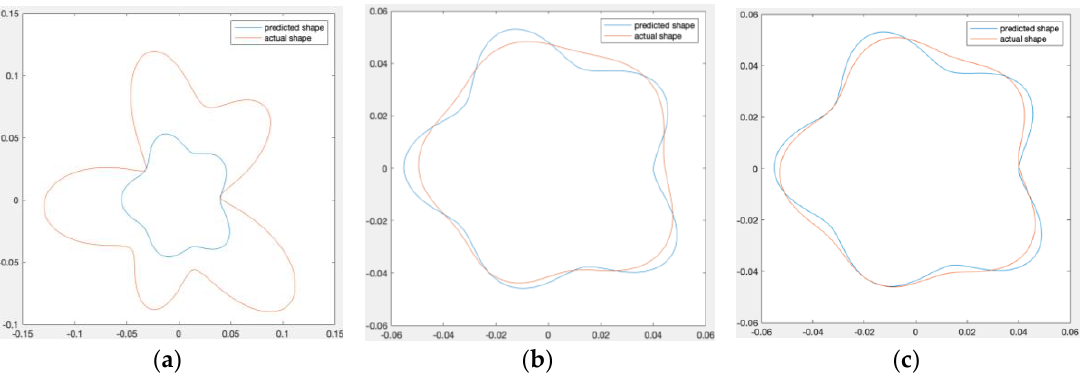
Figure 15. Section of the processed cylinder in position Z = 100mm: predicted data (blue) against actual shape (red). Decreasing error by increasing model complexity steps. All data are in mm. ( a ) Phase shift fix by activating actuators with skipping one revolution for each ( b ) Phase shift and resonance fix by separating revolution speed on the constancy intervals (Step 3) ( c ) Using the diacoptics model, increasing power of actuators (Step 5).